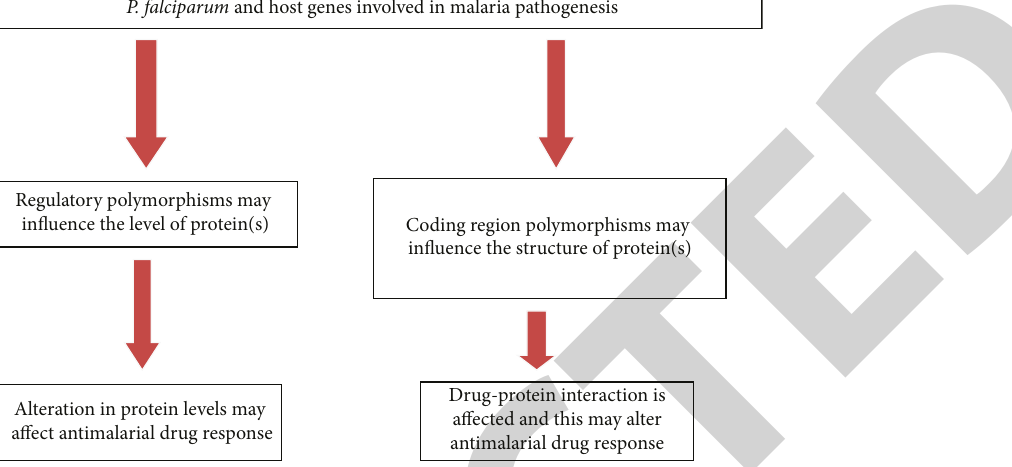
Figure 5: Diagrammatic representation of role of polymorphisms in drug